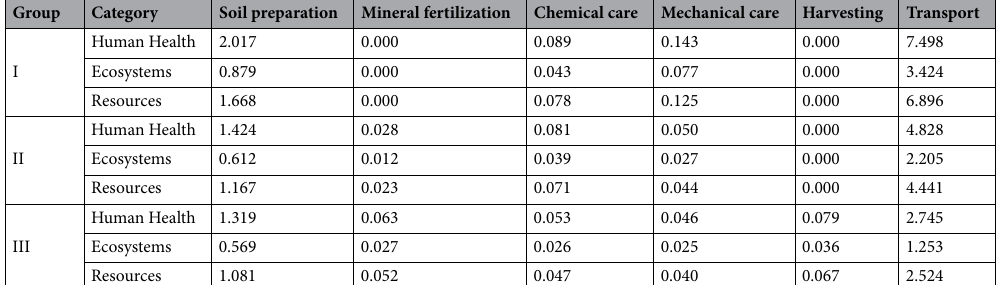
Table 13. The environmental impact of the utilization of technical means of production (processes) as per biomass yield (Pt·tonne −1 ).